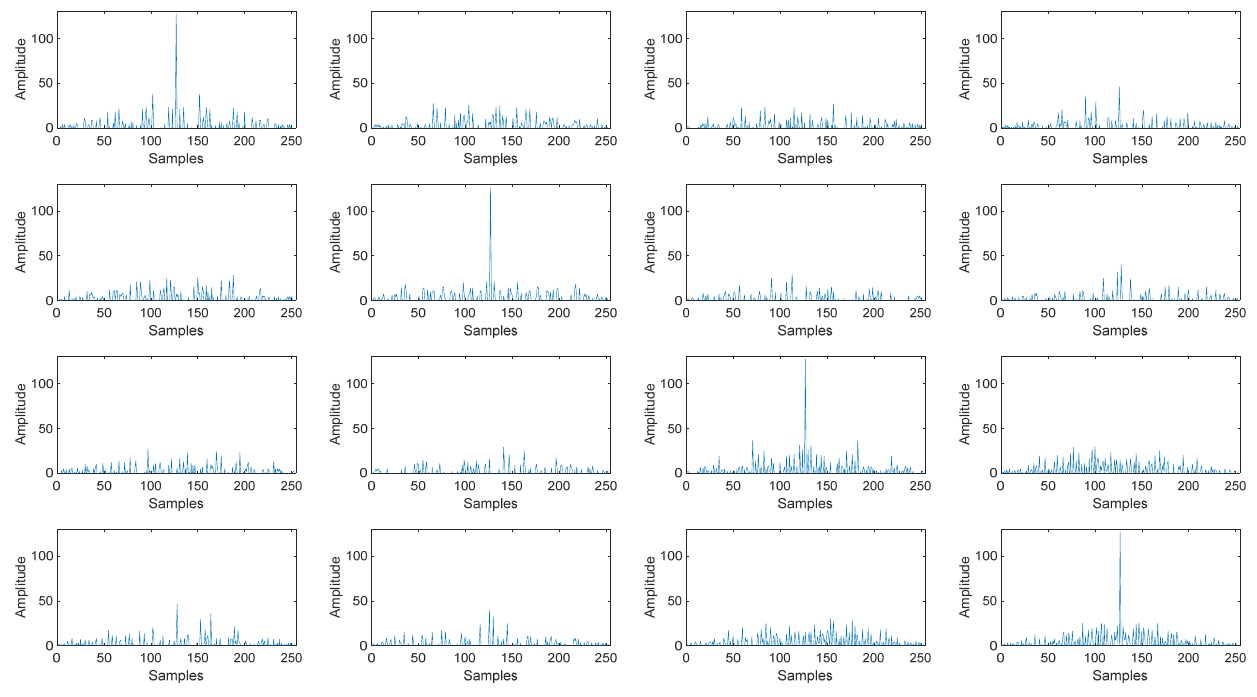
Figure 1. Autocorrelation and cross-correlation of PN sequences.